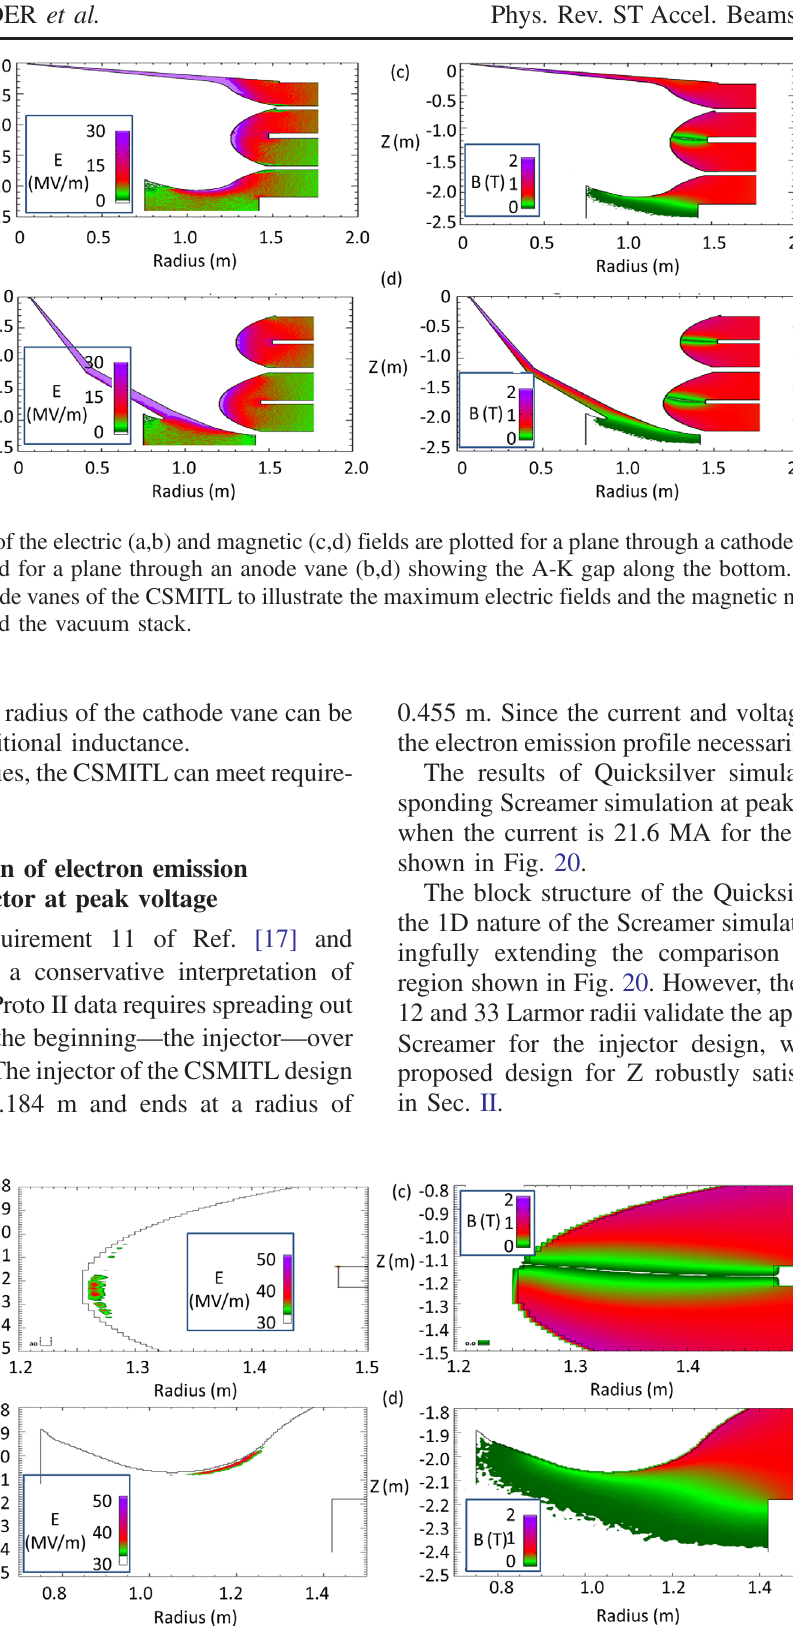
FIG. 19. Detail of the electric (a,b) and magnetic (c,d) field intensities associated with the magnetic null connecting the anode of the vacuum stack to the cathode of the CSMITL. Plots (a,c) show the center anode ring of Z. Plots (b,d) show the bottom anode ring of Z. Electric field intensities above the 33 MV = m threshold for electron emission are